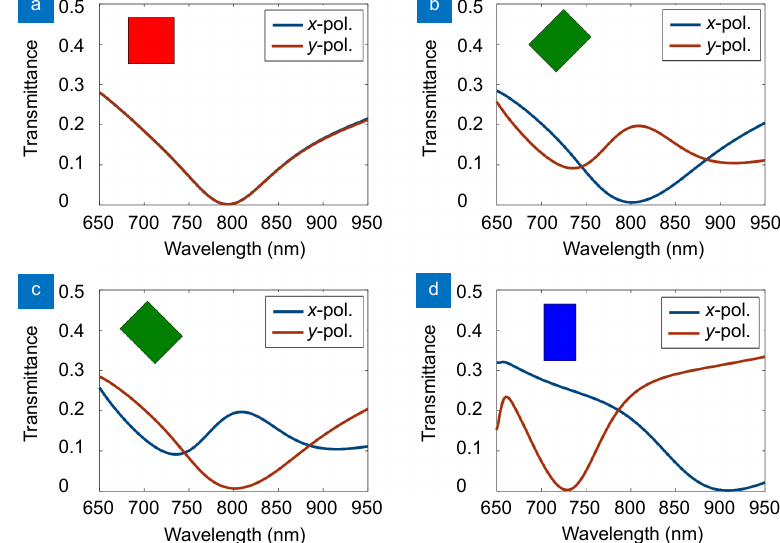
Fig. 2 | All possibilities for binary image (0, 1) synthesis. There are four cases for intensity distributions in the x -polarization and y -polarization, namely, (0, 0), (0, 1), (1, 0) and (1, 1). ( a , d ) show the simulated transmittance for four cases under circularly polarized inci- dence. Rectangles inserted in the figures represent the corresponding nano bars, which have different sizes or rotations and are optimized for 800 nm to meet the requirements. The thickness of nano bars is 30 nm, and the period is 300 nm.